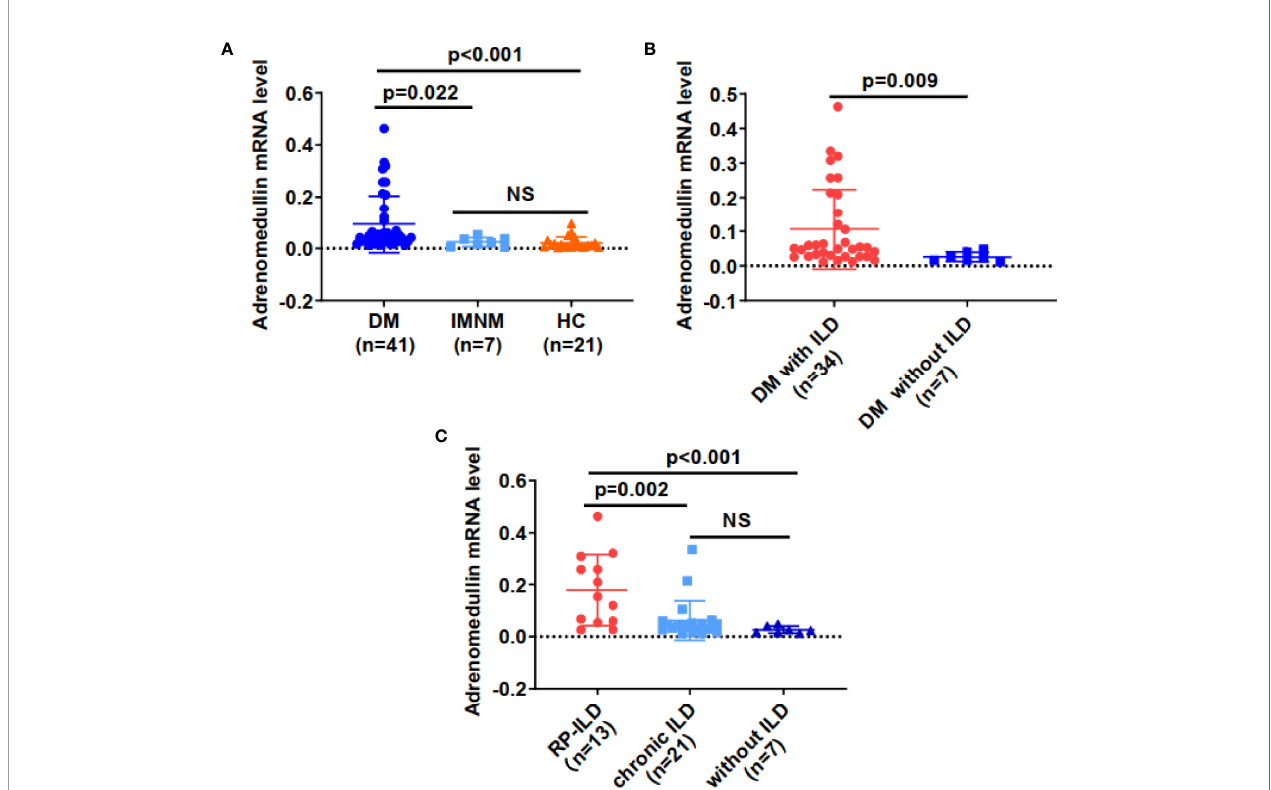
FIGURE 2 | Adrenomedullin mRNA levels from PBMCs were elevated in DM patients with RP-ILD. (A) Adrenomedullin mRNA levels in DM patients were signi fi cantly higher than those in IMNM patients and HCs. (B) Adrenomedullin mRNA levels in DM patients with ILD and those without ILD. (C) The adrenomedullin mRNA levels in DM patients with RP-ILD, chronic ILD, and those without ILD. DM, dermatomyositis; IMNM, immune-mediated necrotizing myopathy; HC, healthy control; ILD, interstitial lung disease; RP-ILD, rapidly progressive interstitial lung disease. NS indicates no signi fi cant difference. Differences between the levels were expressed as relative expression via the 2 - D Ct method. Data were expressed as the mean ± standard deviation